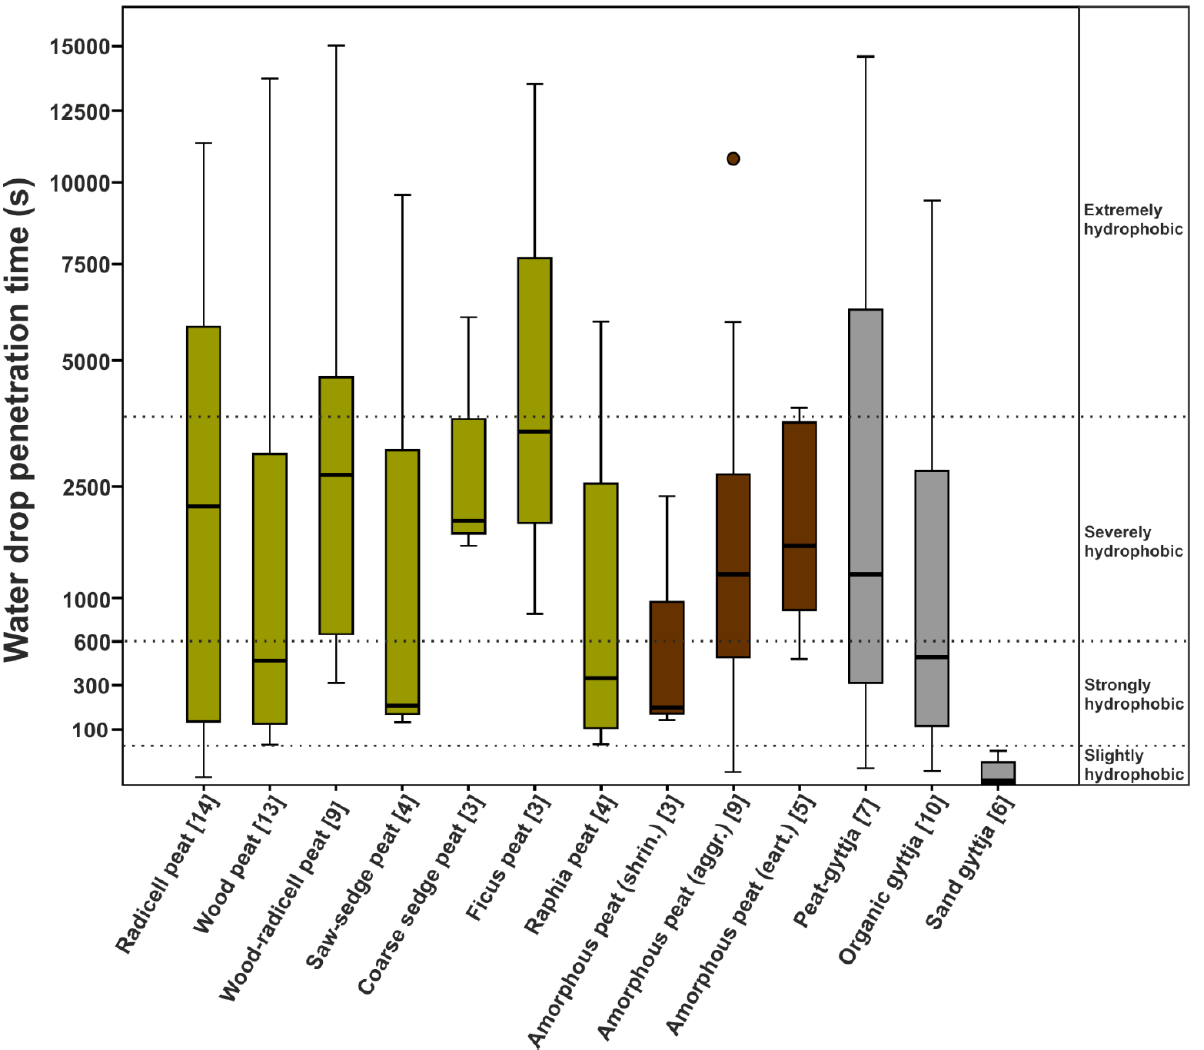
Figure 9. Water drop penetration times for different substrates. Boxes with greenish shading represent undegraded peat substrates; brown indicates amorphous peat; and grey non-peat